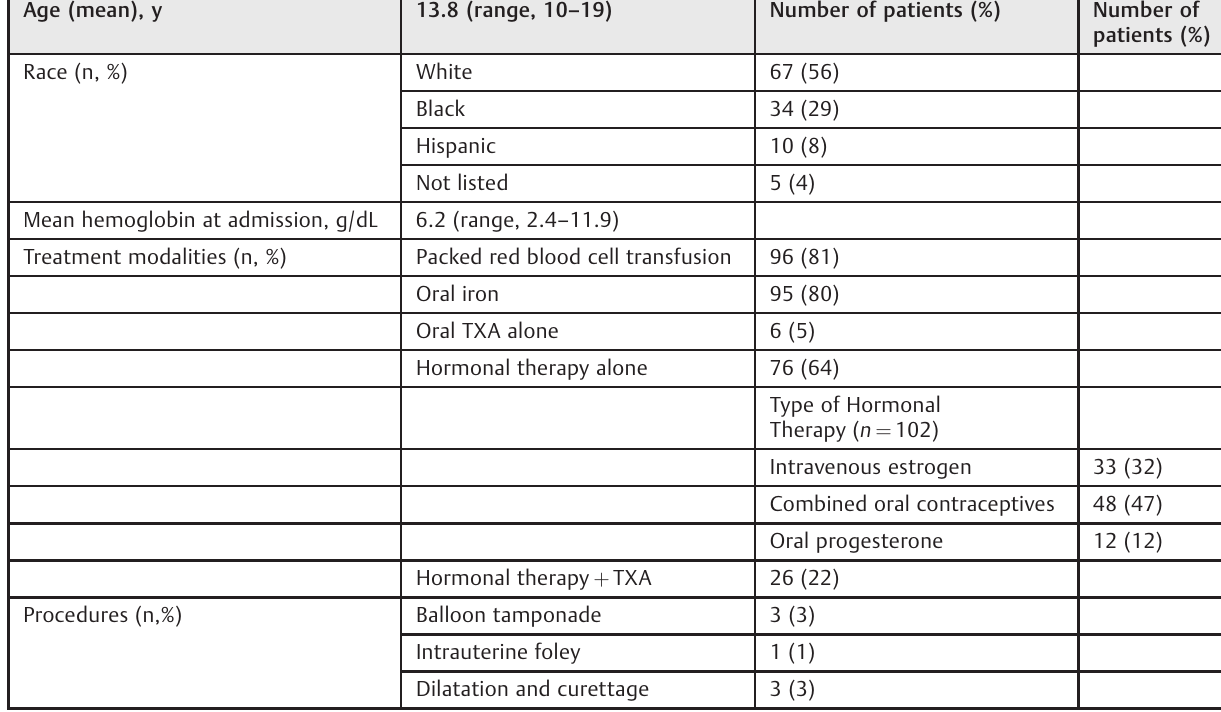
Table 1 Patient